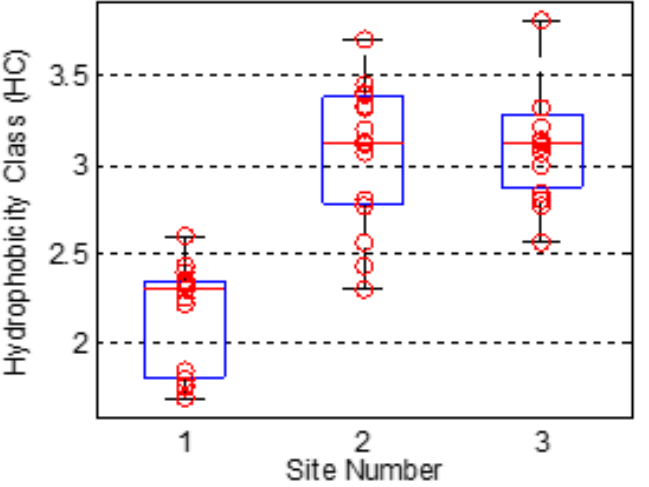
Figure 12. Hydrophobicity classification in the field test.